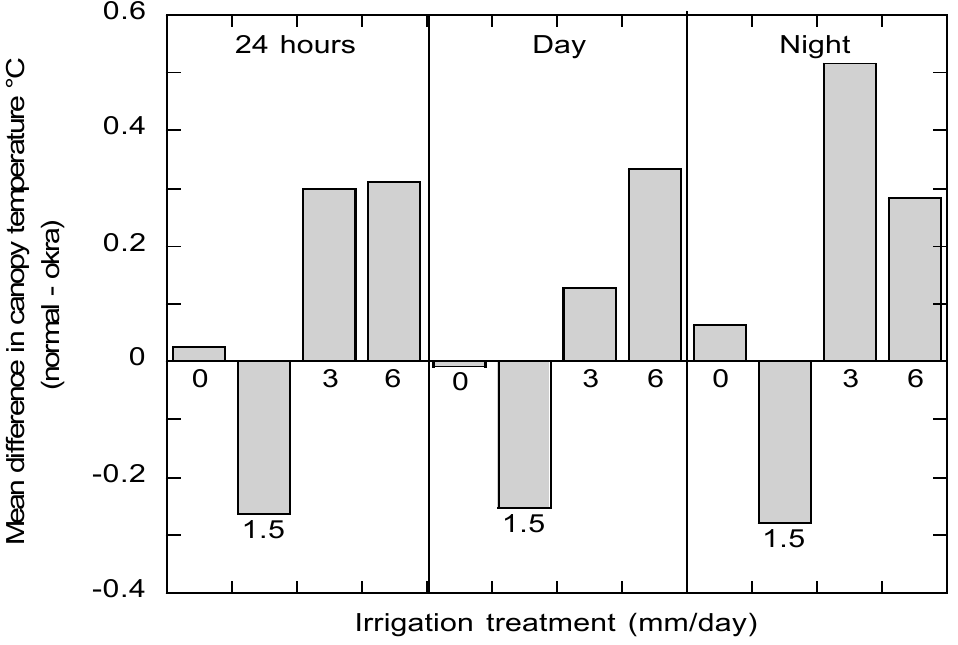
Figure 5. Mean difference in canopy temperature for okra and normal leaf varieties (normal–okra) as a function of irrigation treatment over the 120-day study period. Three periods of the day are shown; 24 h, day, and night.